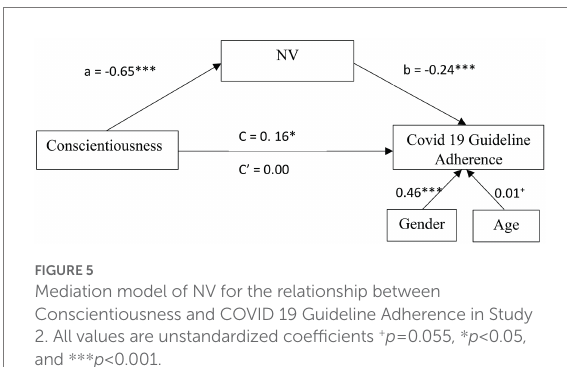
FIGURE 5 Mediation model of NV for the relationship between Conscientiousness and COVID 19 Guideline Adherence in Study 2. All values are unstandardized coefficients + p = 0.055, * p < 0.05, and *** p <